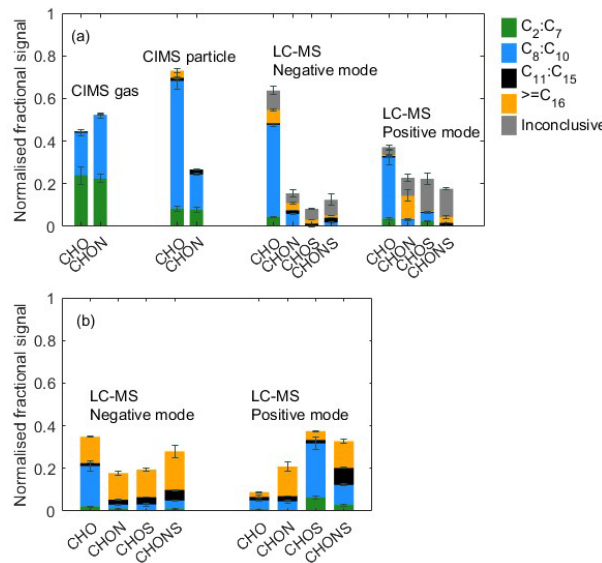
Figure 2. (a) Elemental grouping from CIMS gas-phase measure- ment, CIMS particle-phase measurement, and LC-Orbitrap MS in the α -pinene system. The signal of each compound is normalized to all compounds. (b) Elemental grouping for LC-Orbitrap MS in- conclusive compounds. The signal of each compound is normalized to the total inconclusive compounds. The colours correspond to the ones in panel (a) . Standard deviations ( n = 2 for CIMS and n = 3 for LC-Orbitrap MS) are indicated by error